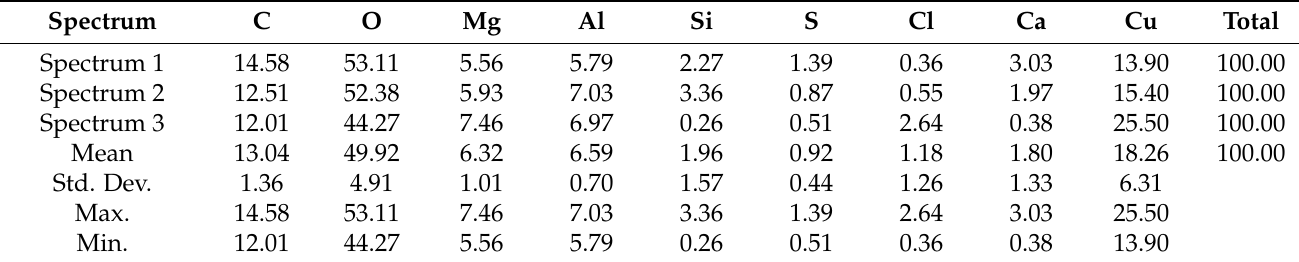
Figure 6. CuAlNi sample exposed after 12 months in the sea. Table 3. Chemical composition in